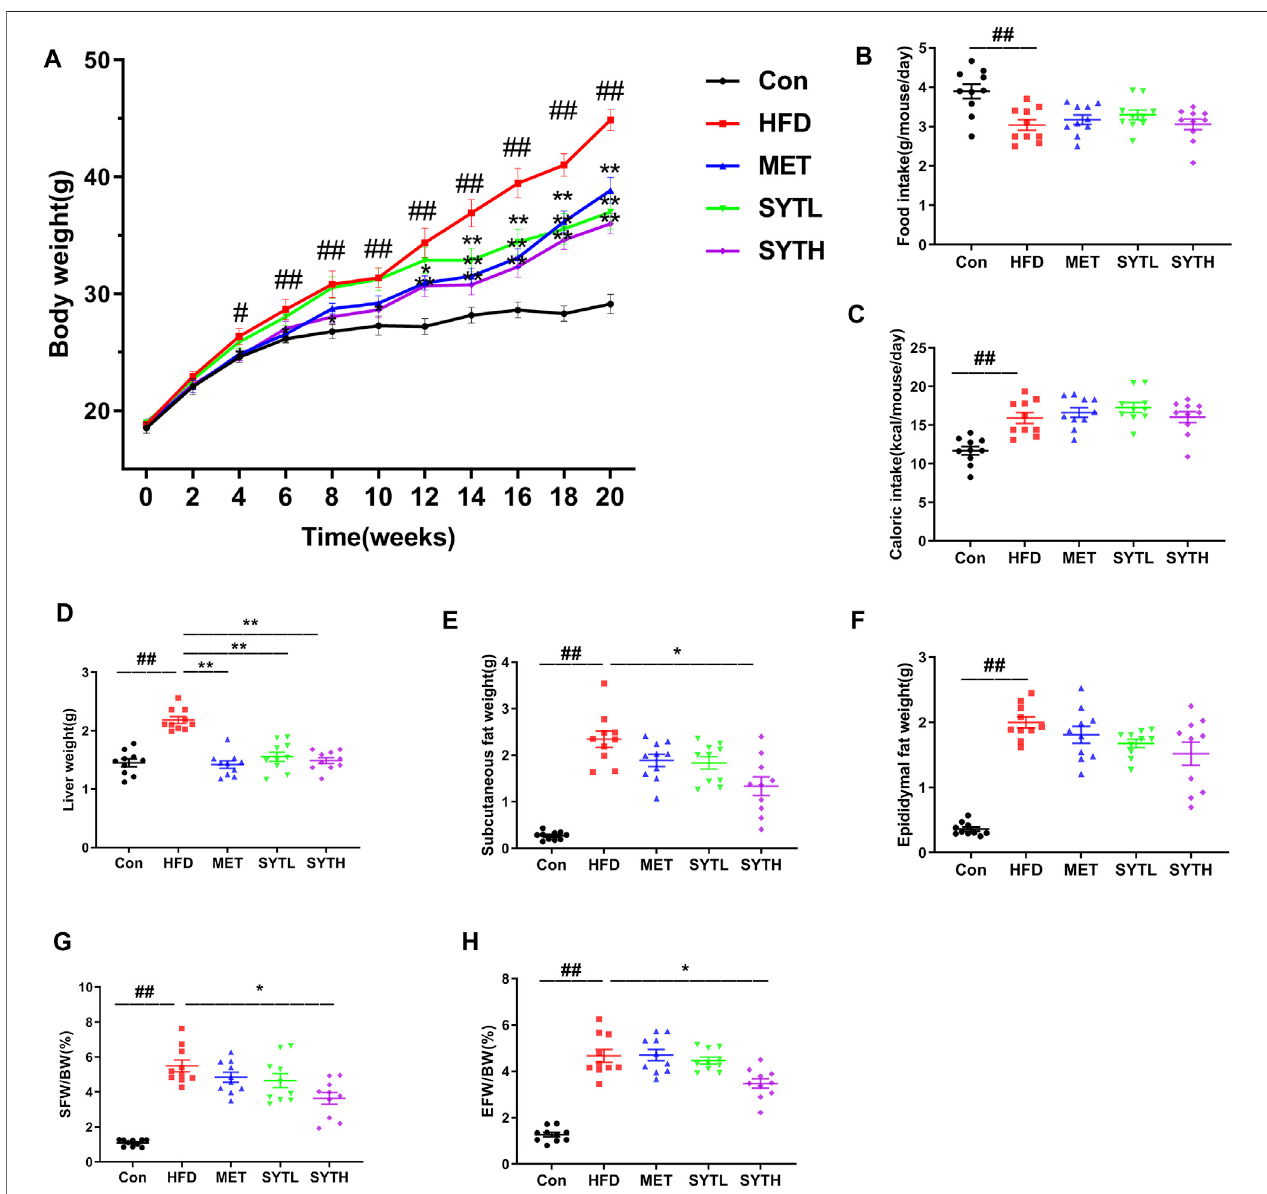
FIGURE 2 | Effects of SYT on body and viscera weight, food and caloric intake in HFD mice. The bodyweight of mice was recorded regularly every week (A) . After treatmentwithSYTfor20 weeks,averagedailyfoodintake (B) ,liverweight (D) ,subcutaneousfatweight (E) ,andepididymalfatweight (F) weremeasured.Averagedaily caloric intake (C) , subcutaneous fat weight/body weight (G) , and epididymal fat weight/body weight (H) were calculated. # p < 0.05, ## p < 0.01 compared with Con group; * p < 0.05, ** p < 0.01 compared with HFD group.